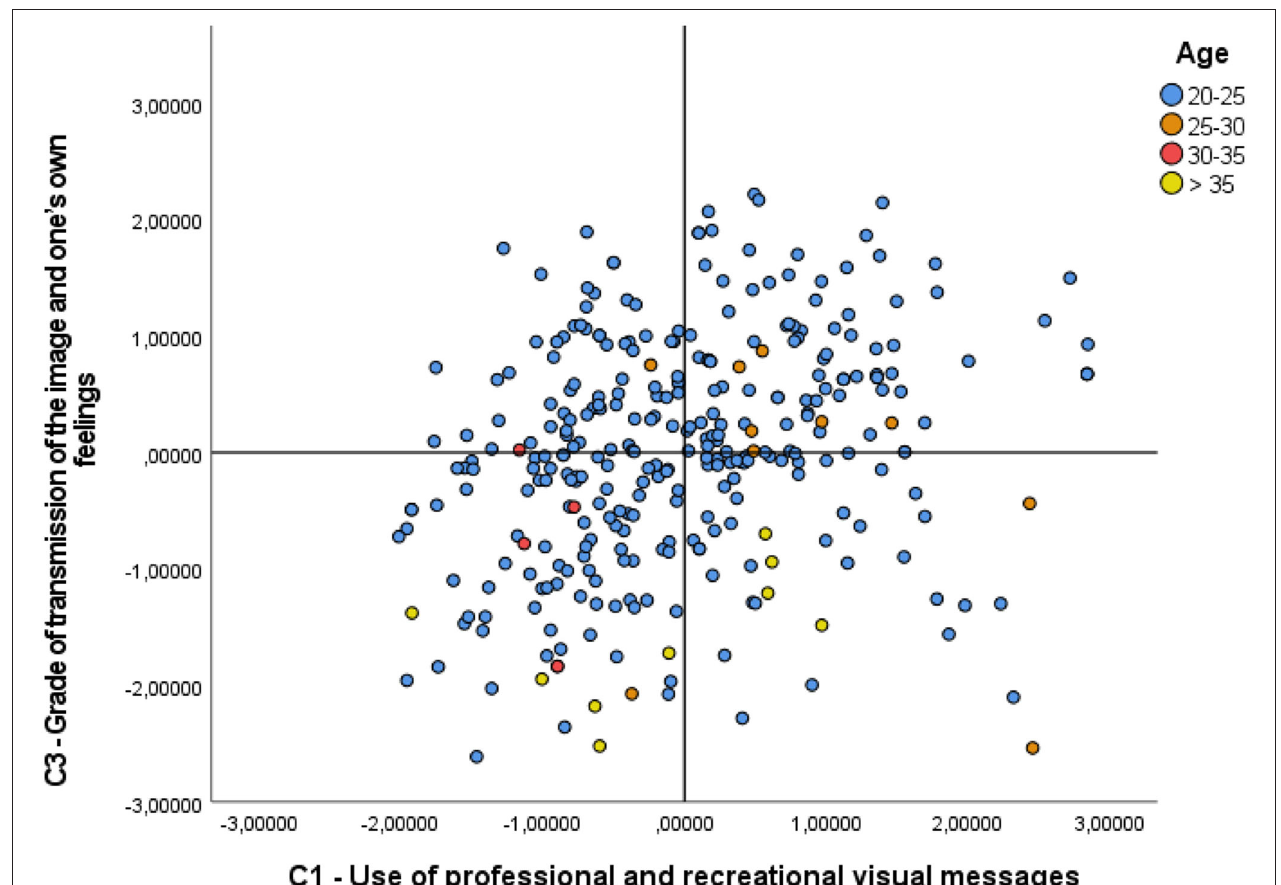
FIGURE 4 | Comparative components 1 and 3 with